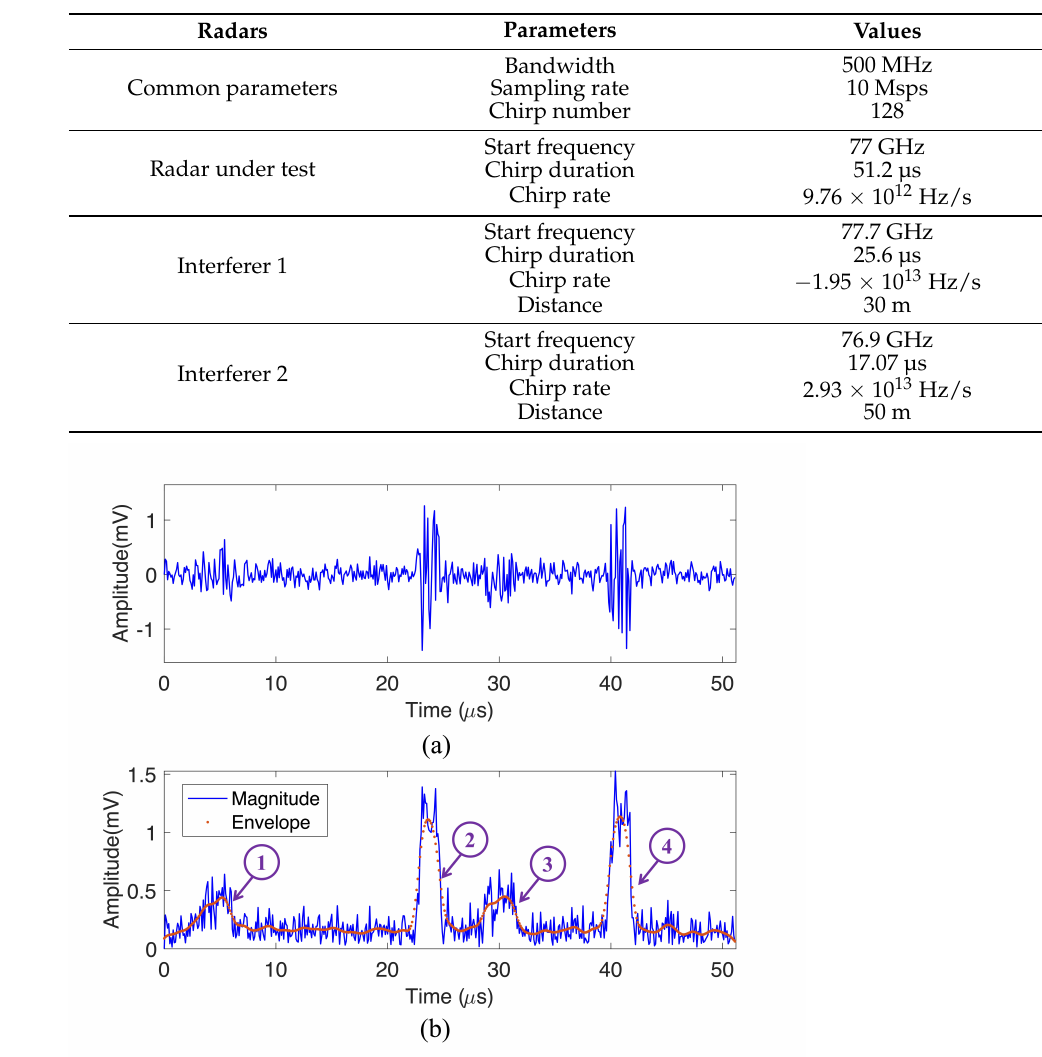
Table 1. Simulation parameters for interference experiments.